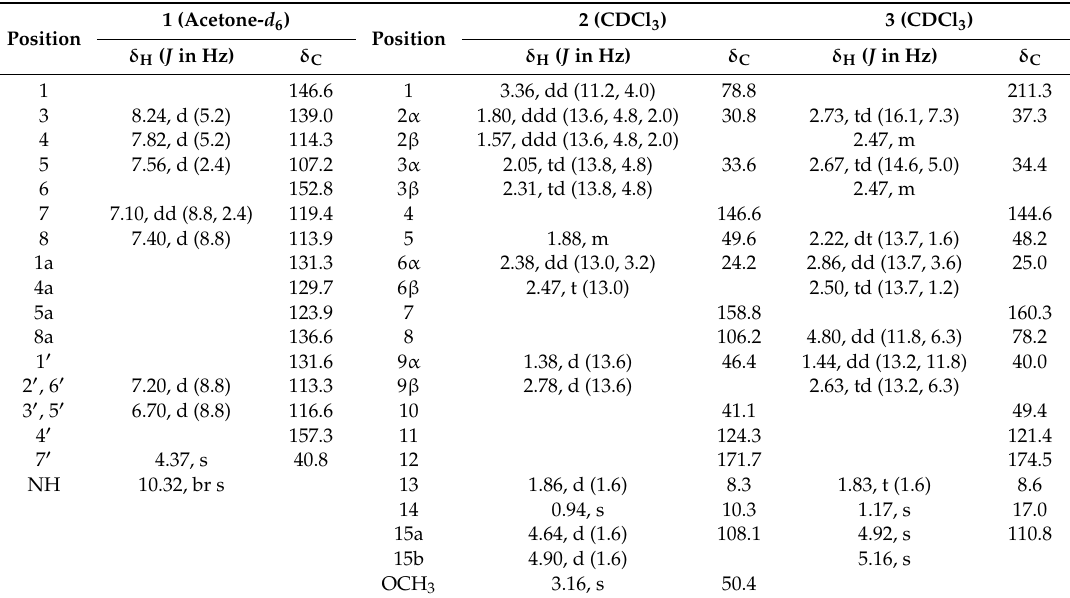
Table 1. 1 H- and 13 C-NMR spectroscopic data of compounds 1 – 3 .